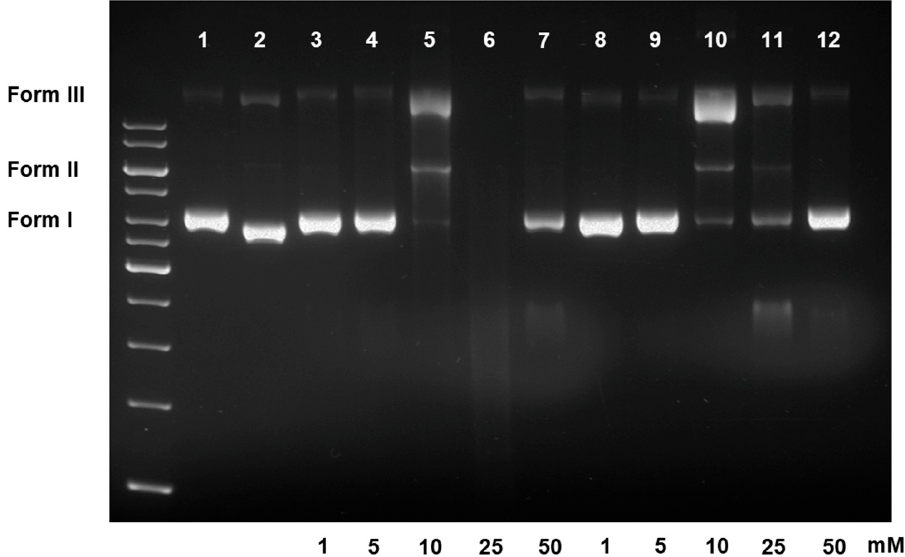
Figure 2. Concentration-responsive effects of compounds 2 and 5 on plasmid DNA; lanes (1) DNA; (2) DNA + cisplatin (10 mM); (3–7) DNA + 2 (1, 5, 25 and 50 mM, respectively); (8–12) DNA + 5 (1, 5, 25 and 50 mM, respectively).